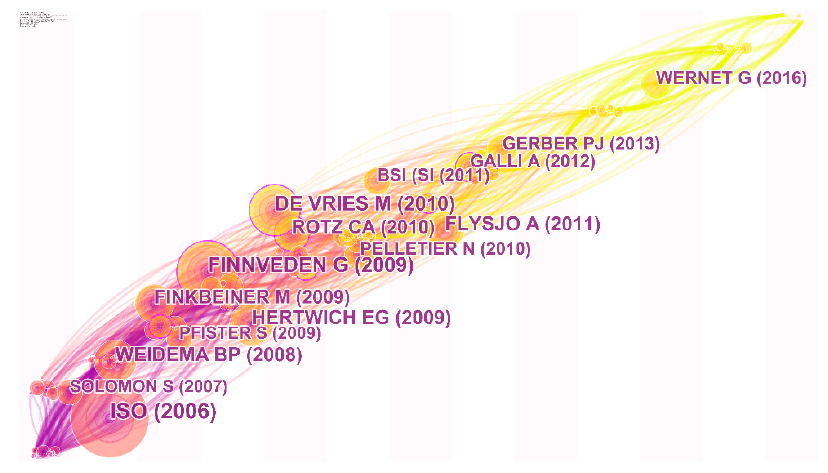
Figure 6. Time-zones of document co-citation.